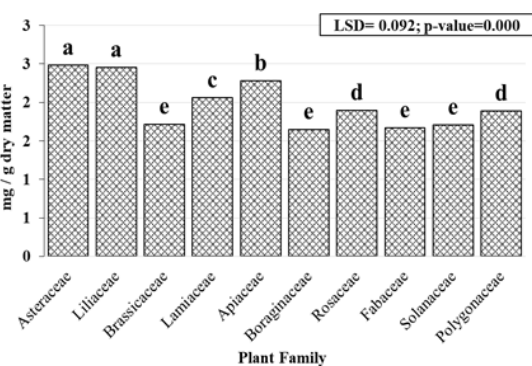
Fig. 5. Antioxidant capacity of plant family regardless of plant species by FRAP method (mg/g dry matter equivalent to mg ammonium ferrous sulfate/g dry matter).